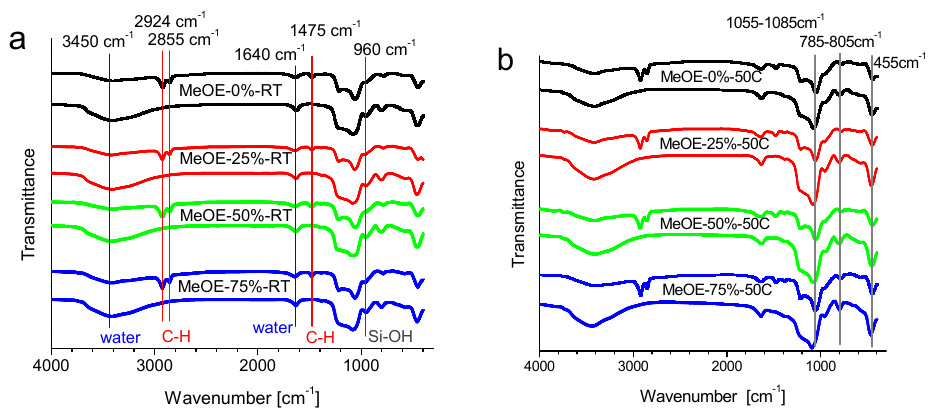
Figure 1. FT-IR spectra of mesoporous silica synthesized at room temperature ( a ) and at 50 °C ( b ), before and after calcination. Vertical lines in panel ( a ) show the characteristic bands of CTAB that disappear after thermal treatment (red); the vibrations related to water (blue) and Si-OH vibrations (dark grey). The vertical lines in panel ( b ) show the characteristic bands of the silica network.